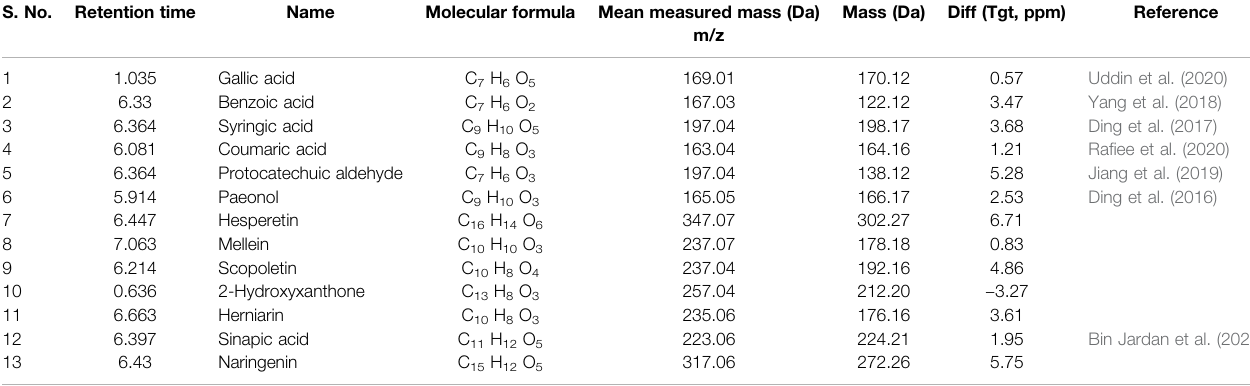
TABLE 1 | QTOF-ESI-MS data of identi fi ed plant metabolites from hydroalcoholic extract of DP in negative mode [M − H] − with the possible molecular formula. S. No. Retention time